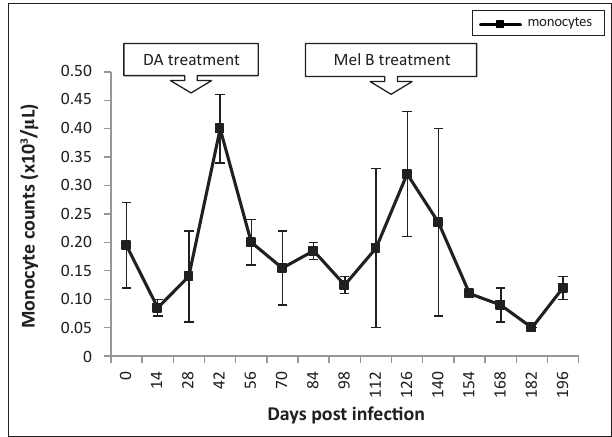
FIGURE 8: Mean changes in monocyte counts of T. b. brucei GUTat 1-infected vervet monkeys, showing the point of subcurative treatment with diminazene aceturate (DA) (28 dpi) and curative treatment with melarsoprol (Mel B) (119